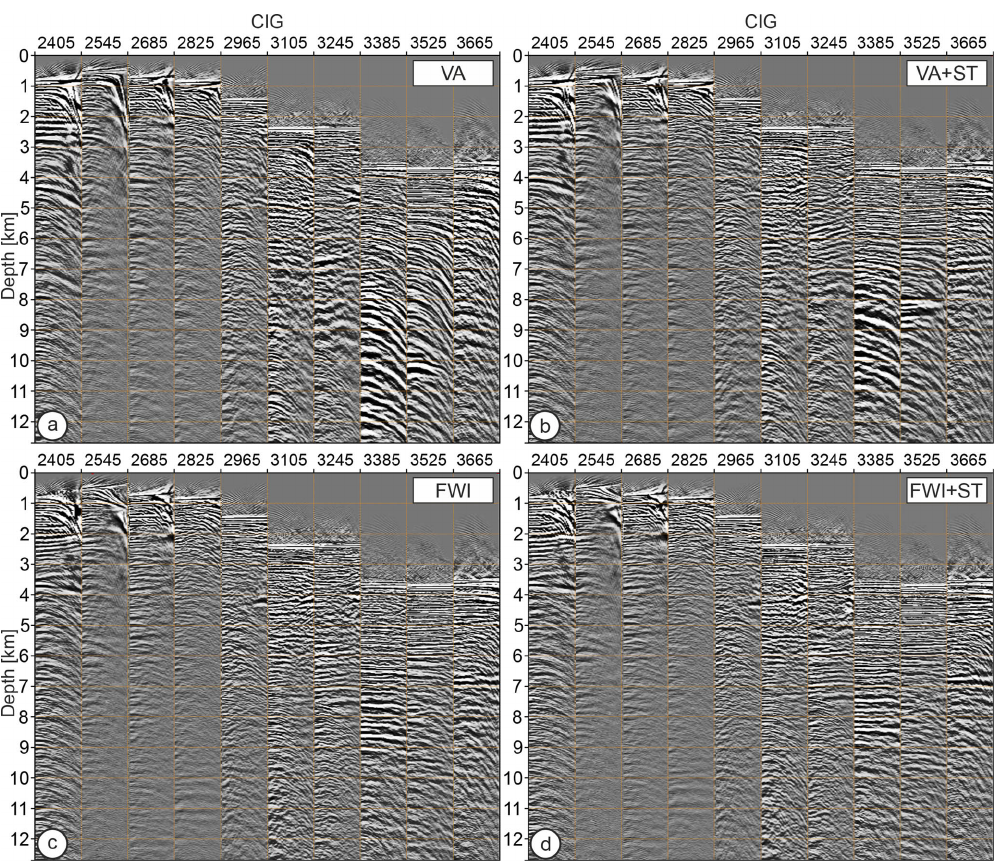
Figure 9. CIGs extracted along the whole profile (every 8.75km). (a–b) CIGs inferred from the velocity model built by (a) VA and